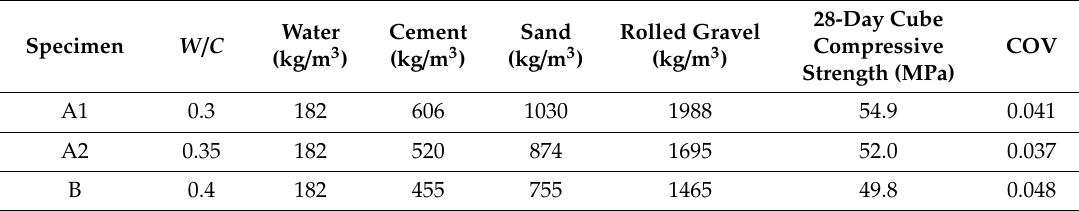
Table 1. Concrete composition and strengths.